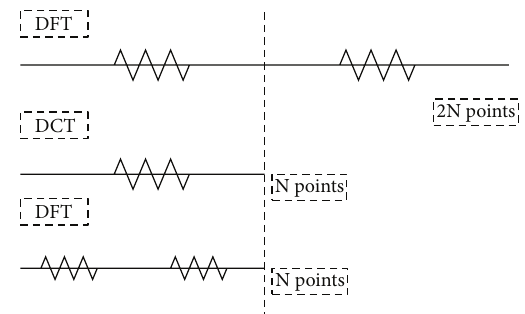
Figure 2: Comparison of coefficients of DCT and